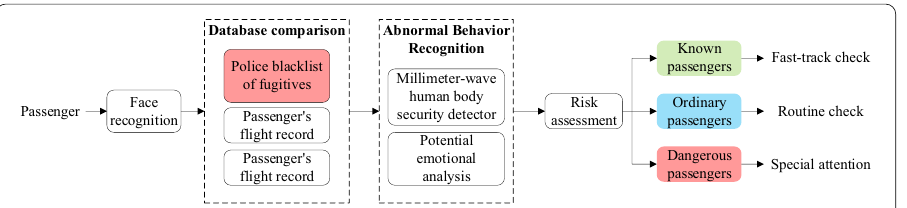
Fig. 3 Process of graded passenger security check based on risk assessment; illustration of the process of graded passenger security check based on risk assessment. The green box represents known passengers, the blue box represents ordinary passengers and the red box represents dangerous passengers